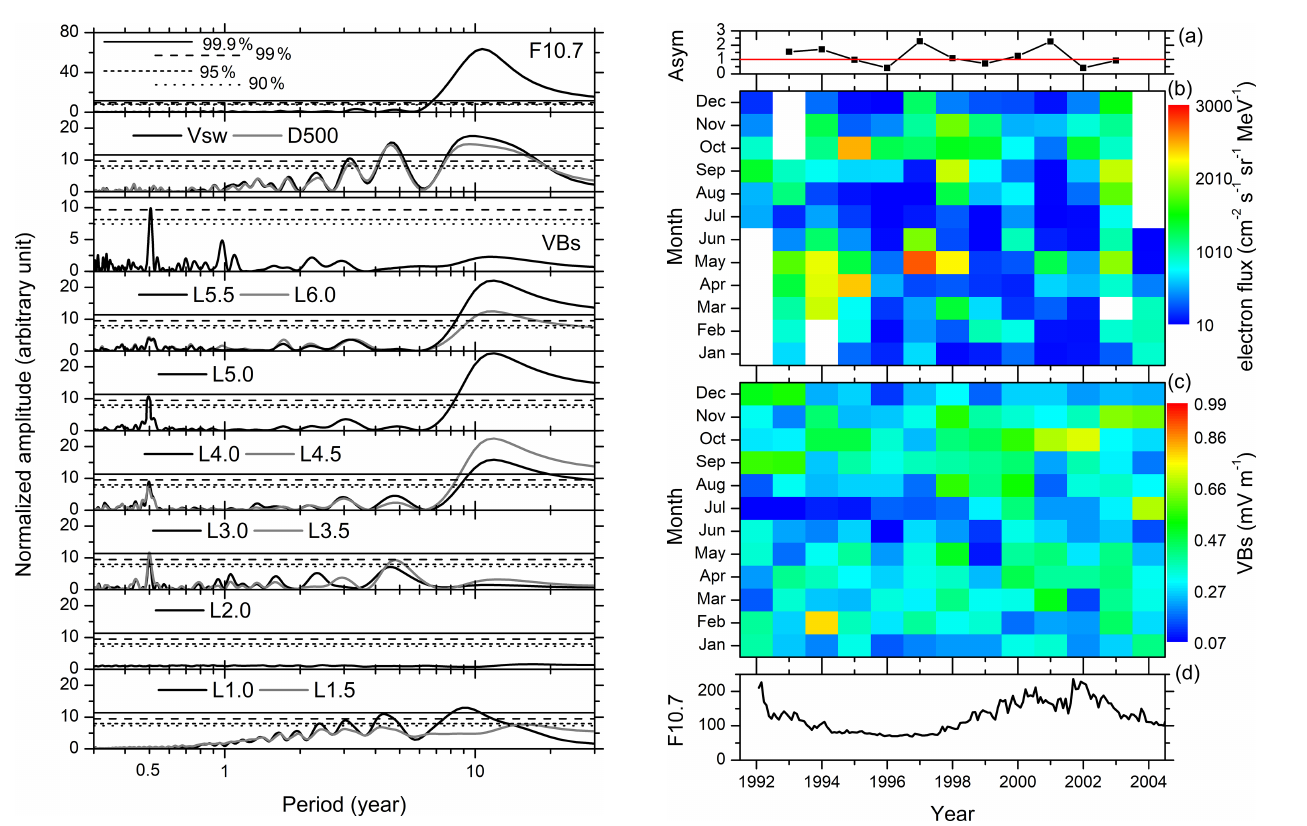
Figure 3. Contour plots in panels (b) and (c) show the monthly mean 1.5–6.0MeV electron fluxes at L = 3 . 5 and monthly mean V B s , respectively, during each month for the years 1992 through 2004. Panel (a) shows seasonal asymmetry (defined in the text), and panel (d) shows the F10.7 solar flux during the same